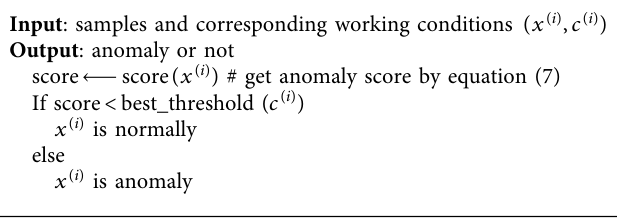
A LGORITHM 2: Anomaly detection